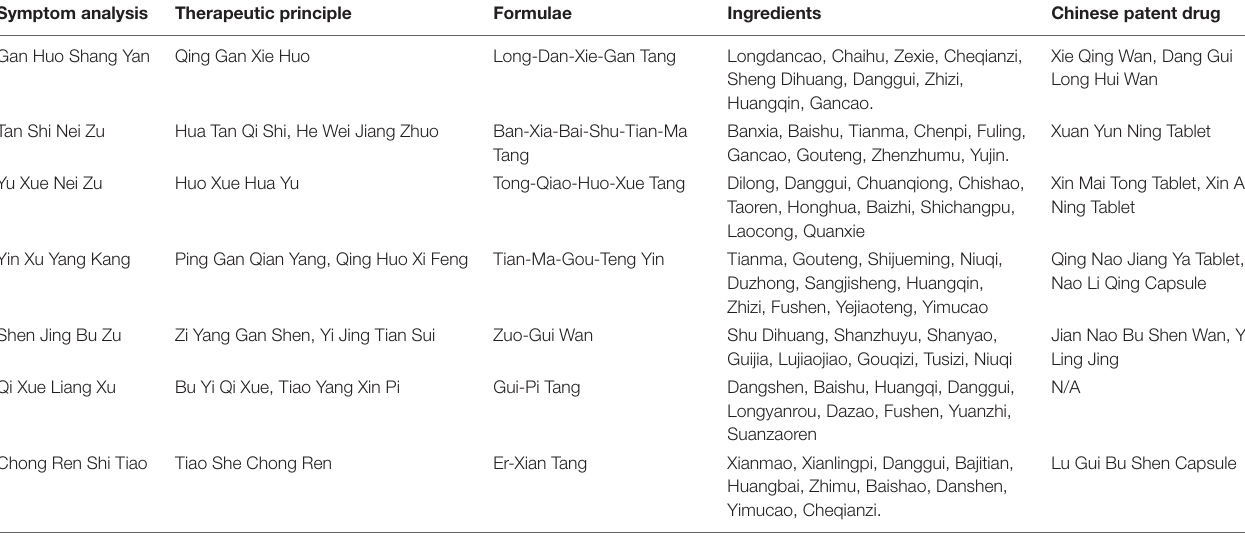
TABLE 1 | Formulae for hypertension based on syndrome